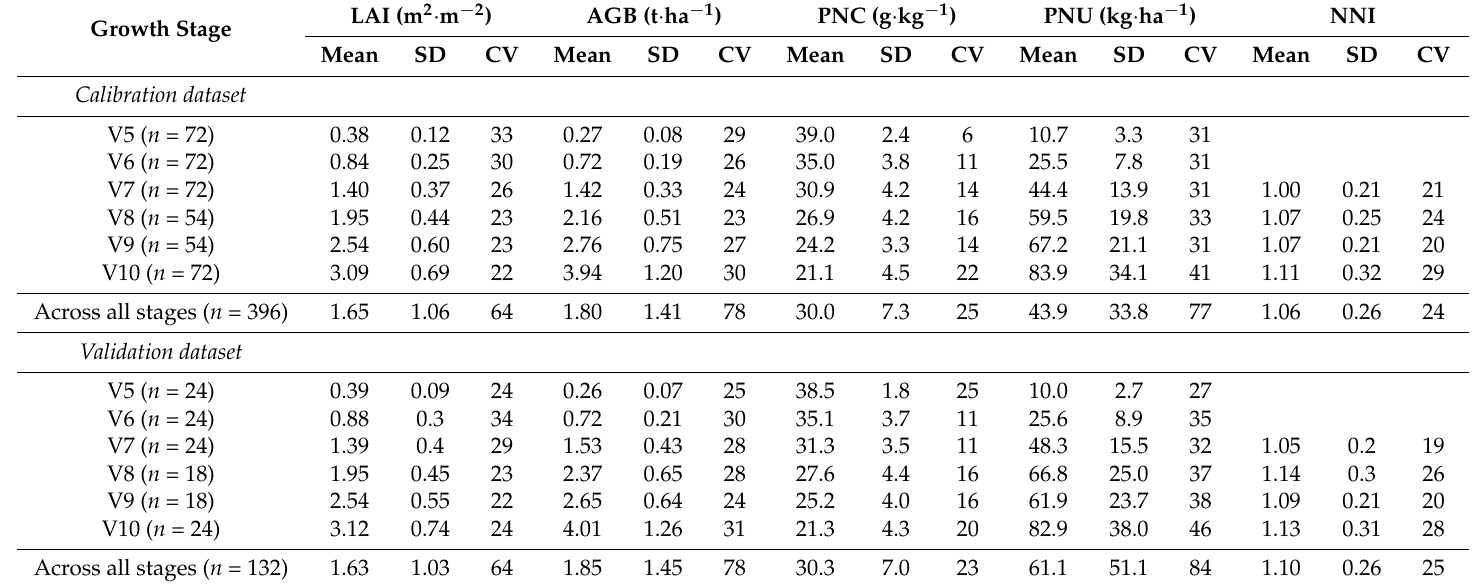
Table 2. Descriptive statistics of spring maize leaf area index (LAI), aboveground biomass (AGB), plant N concentration (PNC), plant N uptake (PNU) and N nutrition index (NNI) for calibration and validation datasets at different growth stages across 2014 and 2015.